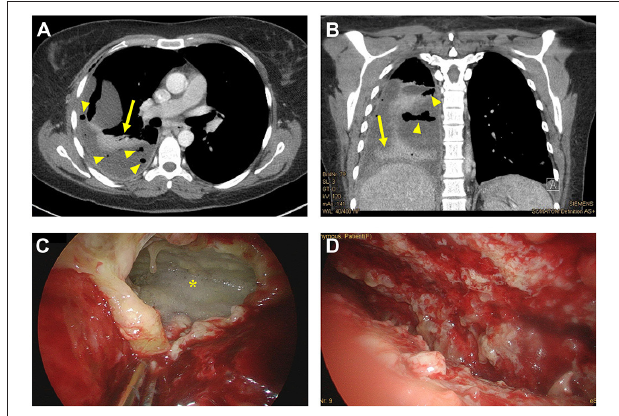
FIGURE 2 | (A,B) Computed tomography (CT) scan [axial (A) and coronal plane (B) ] of the chest showing pleural effusion rim enhancement (arrow)